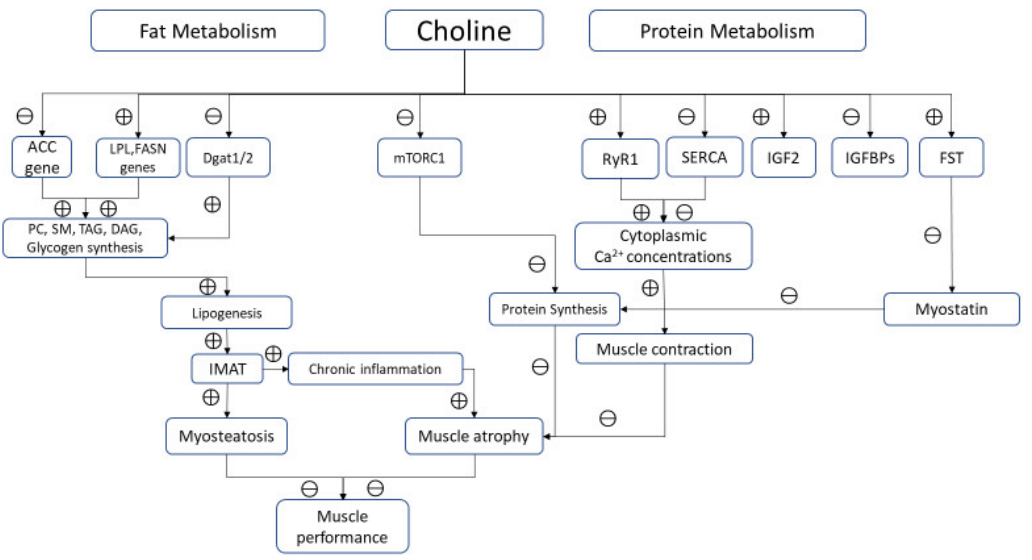
Figure 2. Biological pathways modulated by choline in skeletal muscle. Note: ⊕ and ⊖ indicate positive and negative modulation, respectively.